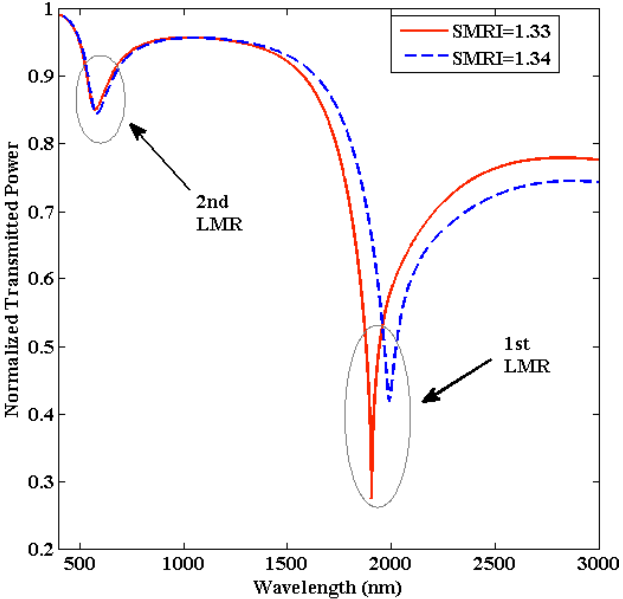
Figure 3. Transmitted LMR spectra for the proposed ITO-coated U-shaped fiber optic LMR sensor. Here, ITO thickness (d) = 90 nm, L = 0.5 cm, and R = 1.0 cm.